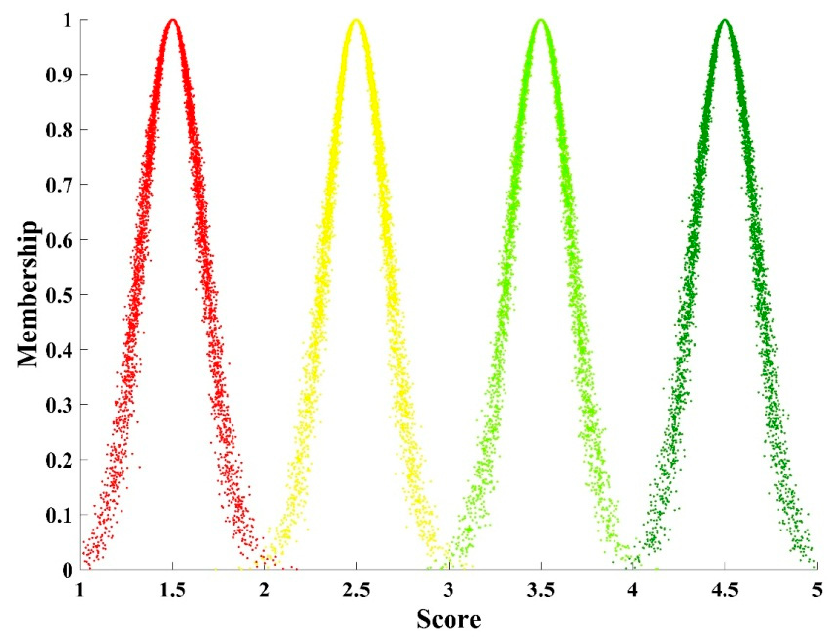
Figure 3. Scored standard cloud.